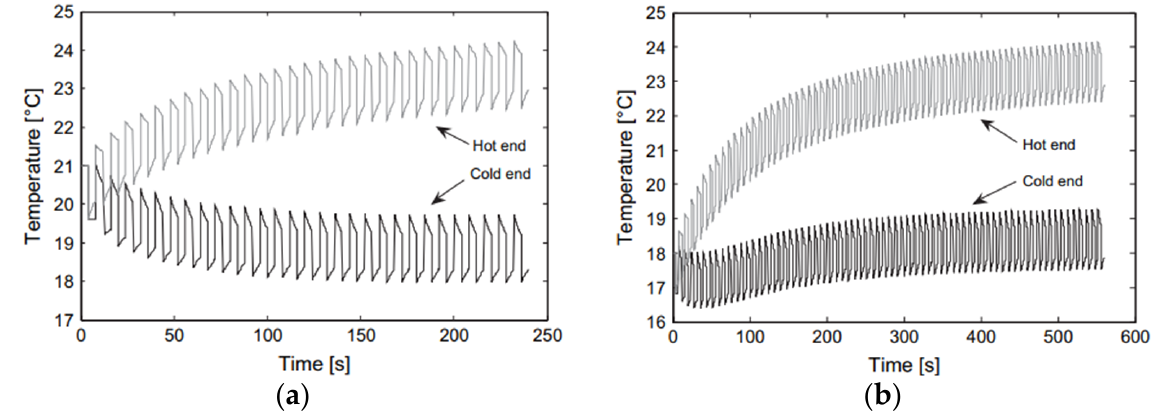
Figure 29. Temperature distribution through the regenerator versus the time after the magnetiza- tion [57].